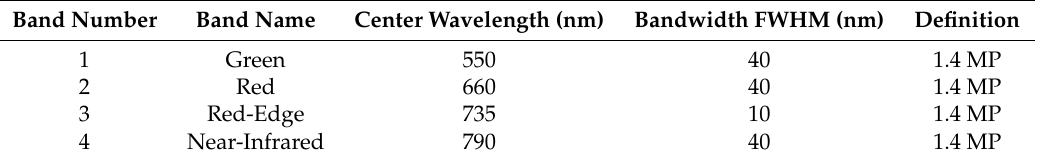
Table 1. Specifications of the multispectral sensor used in this